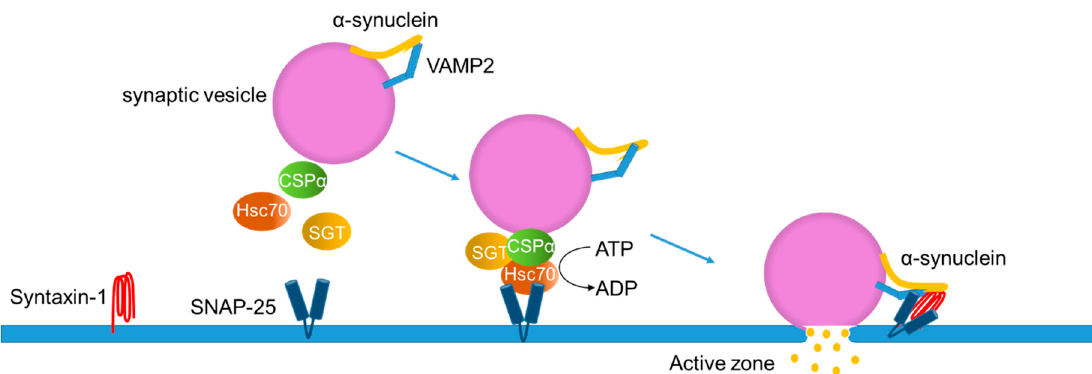
Figure 3. Proposed model for the physiological functions of α -synuclein in exocytosis. Cysteine string protein- α (CSP α ) forms a complex with the heat-shock cognate 70 (Hsc70) and small glutamine-rich tetratricopeptide repeat-containing protein (SGT) on the synaptic vesicle. The tertiary complex binds to SNAP-25, a protein localized on the target membrane, to promote formation of the SNARE complex. The C-terminal region of α -syn binds to VAMP2 on the synaptic vesicle, assisting in the SNARE complex assembly together with the plasma membrane SNARE protein, syntaxin-1. Adapted from [67] .